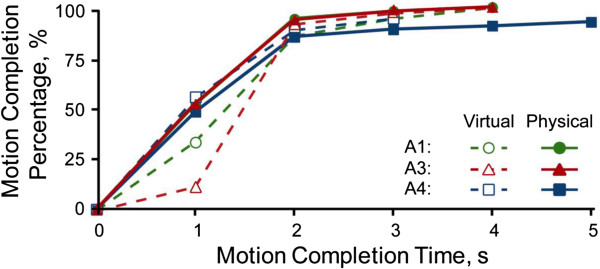
Cumulative motion completion percentage comparing performance between the physical prosthesis and the virtual prosthesis for three transfemoral amputees.